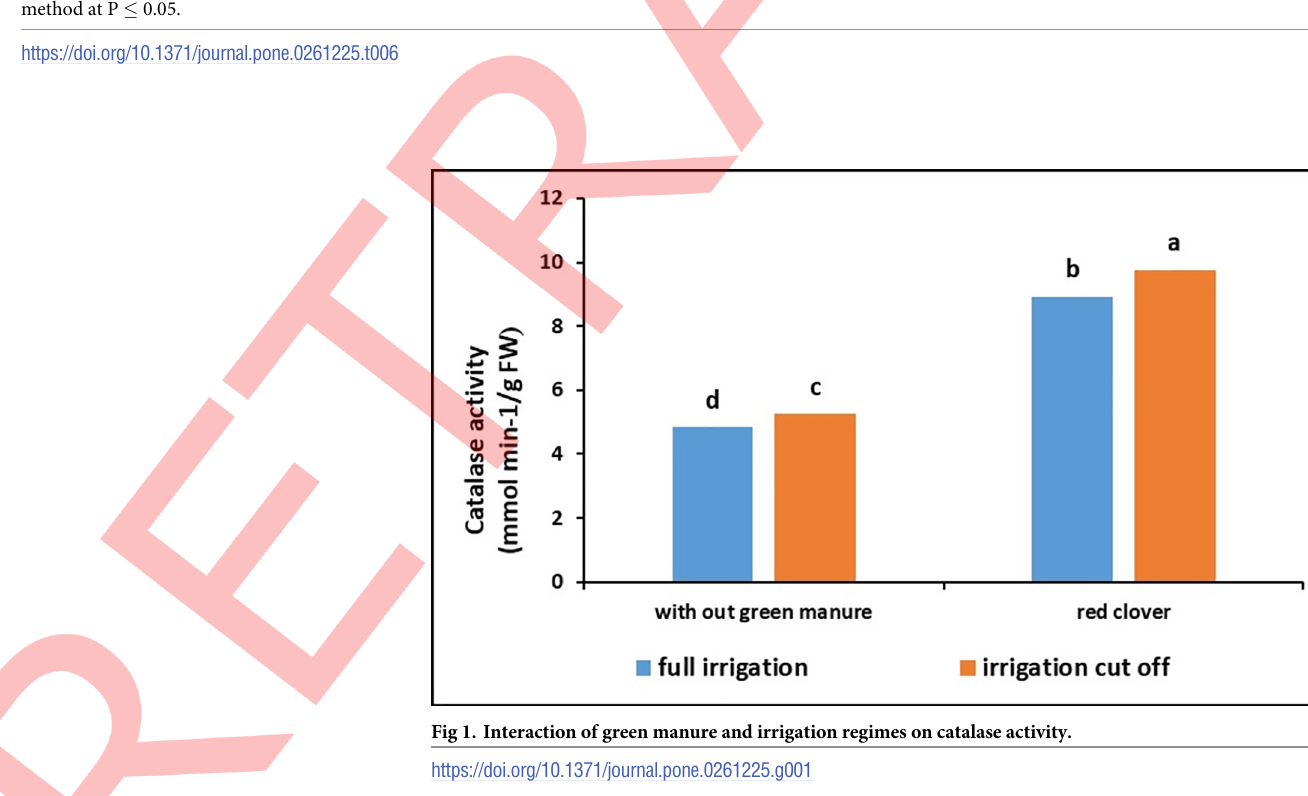
PLOS ONE | https://doi.org/10.1371/journal.pone.0261225 December23,